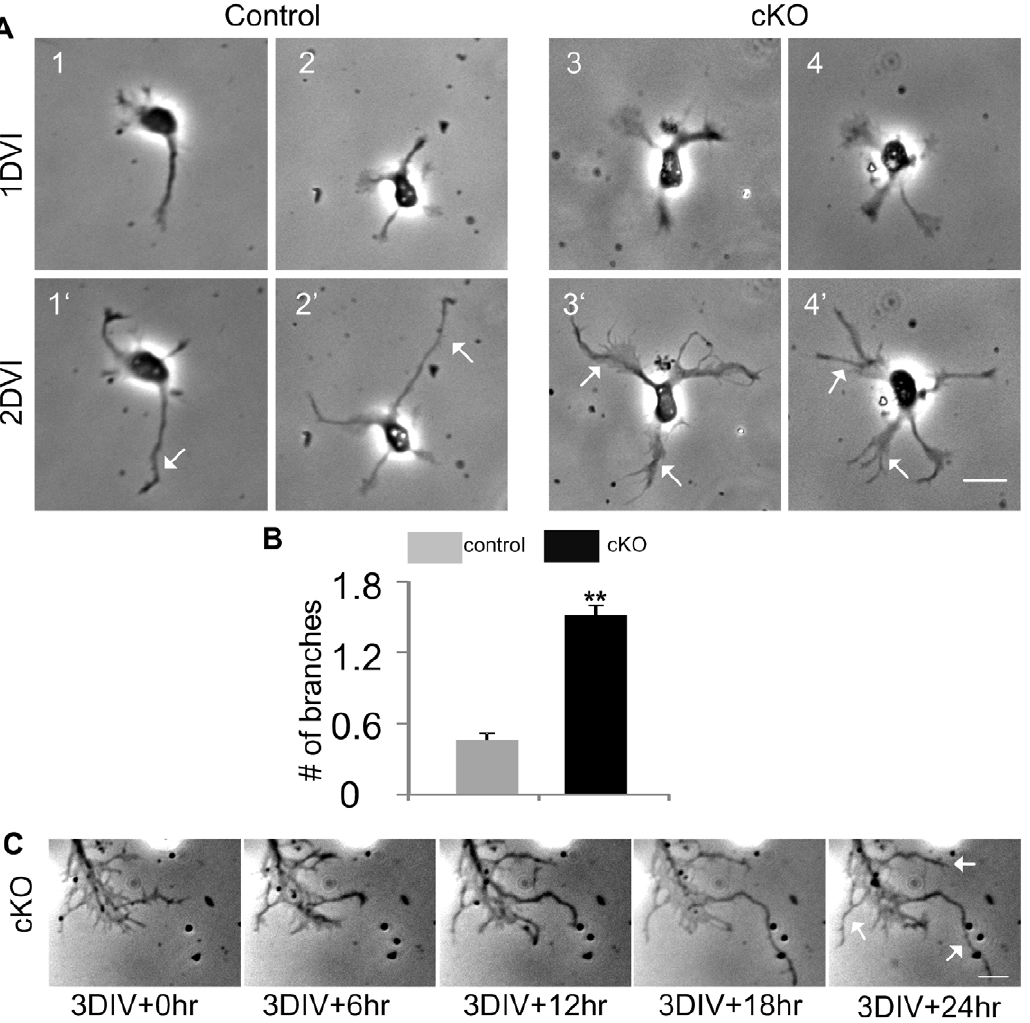
Figure 2. APC deletion induces growth cone splitting. (A) Representative images of the same neurons taken at 1DIV (top panel) and 2DIV (bottom panel) from control and APC deleted embryos. Note that control growth cones normally remain intact (1 9 and 2 9 , arrows) at 2DIV, while APC deficient growth cones split into multiple branches (3 9 and 4 9 , arrows). (B) The average number of branches that emanated from control and APC deficient growth cones at 2DIV. (C) Phase-contrast images of an APC cKO axon observed over 24 hr in time lapse. Cortical neurons from around E15 embryos were cultured for 3 days in vitro before imaging. **: P , 0.005 by two-tailed student t-test. Data are presented as mean 6 SEM. Scale bars: 20 m m.